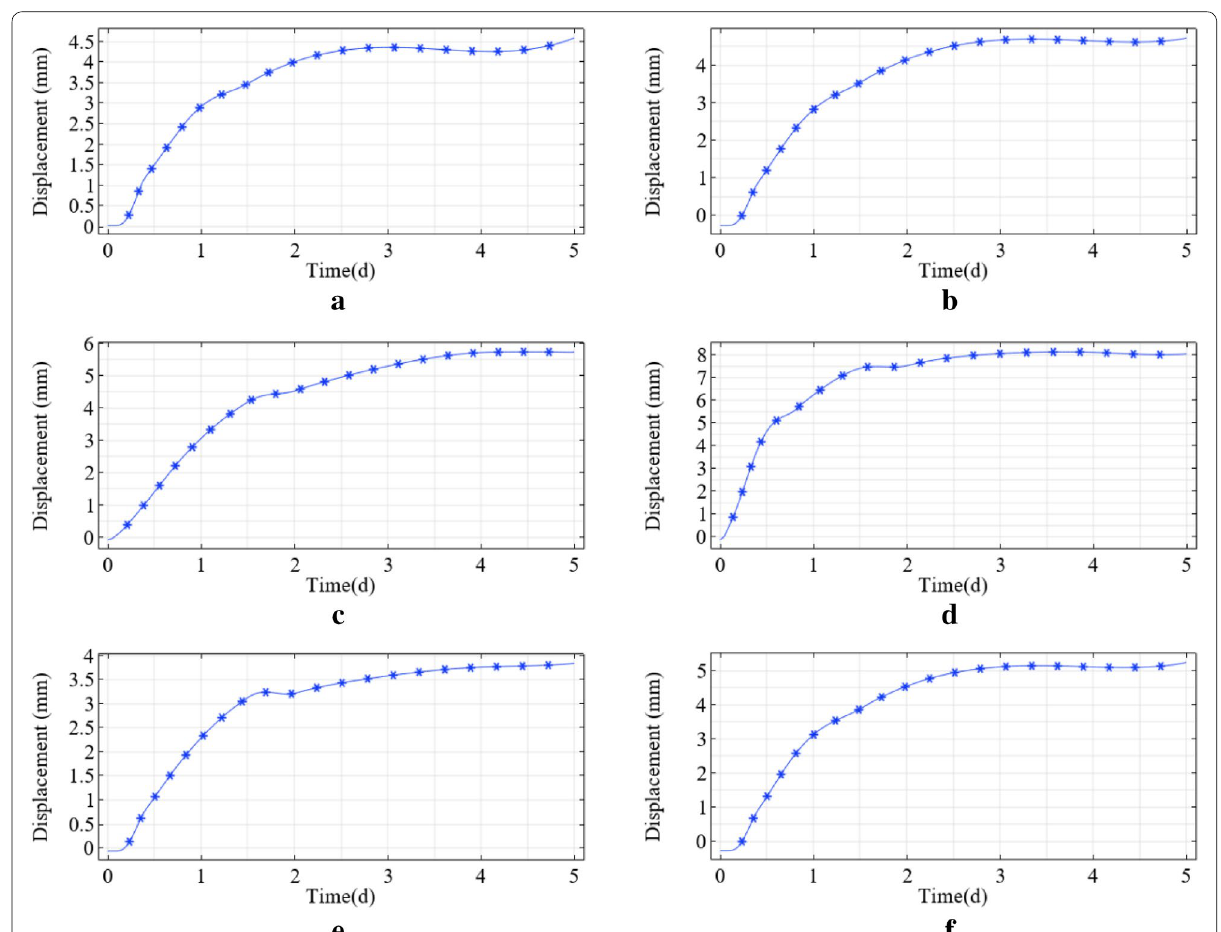
Fig. 8 Evolution of the simulated barricade displacement with time corresponding to the data of D1 ( a ), D2 ( b ), D3 ( c ), D4 ( d ), D5 ( e ) and D6 ( f